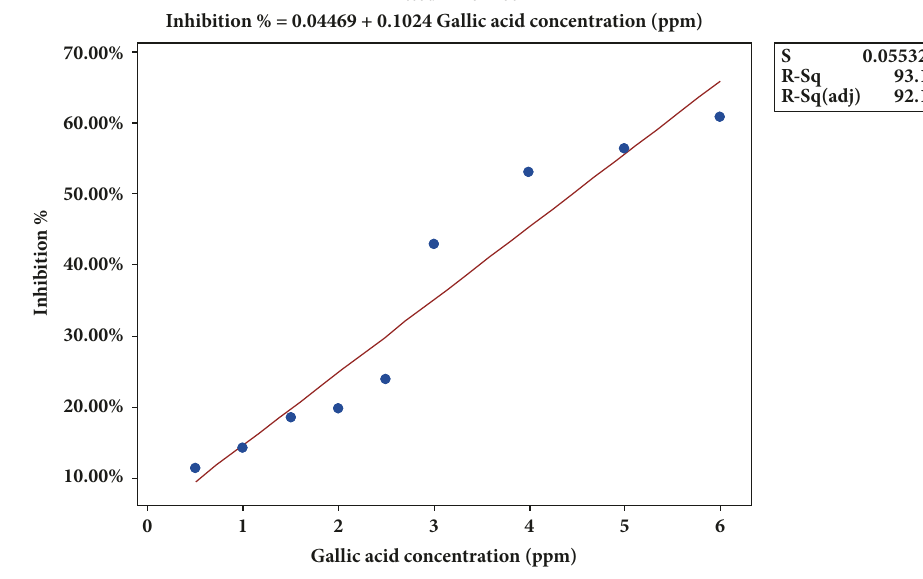
Figure 1: Standard curve for gallic